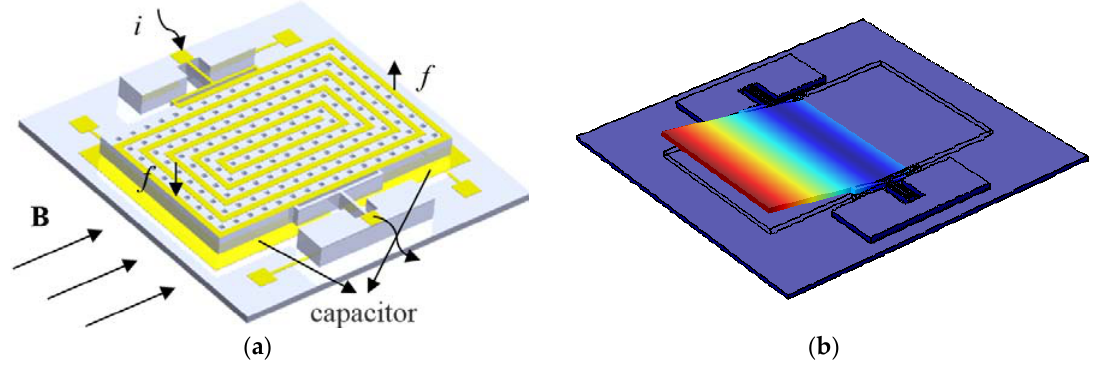
Figure 1. ( a ) Schematic diagram of magnetometer; ( b ) operation vibration mode via FEM simulation.